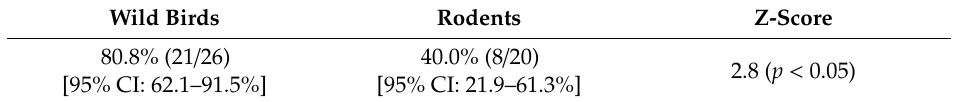
Table 3. Percentage of E. coli isolates from wild birds and rodents resistant to at least one